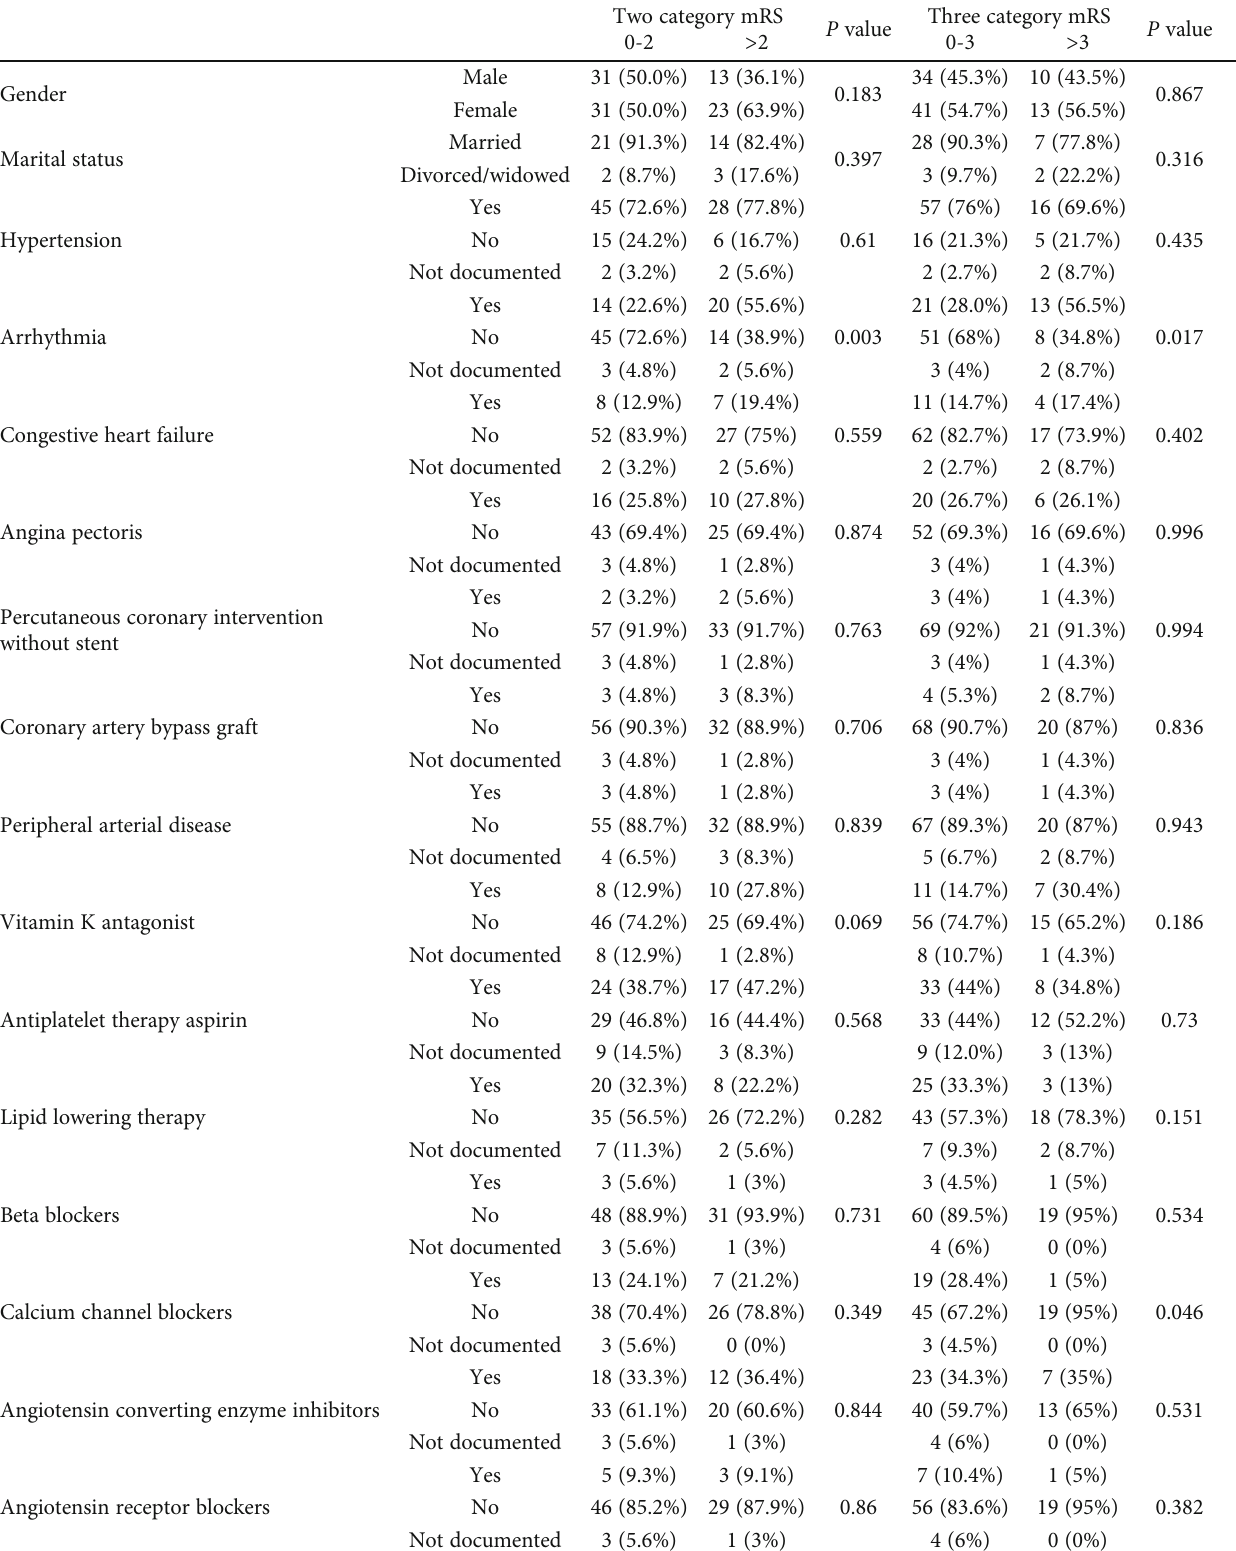
Table 2: E ff ects of demographics and past medical history on mRS at